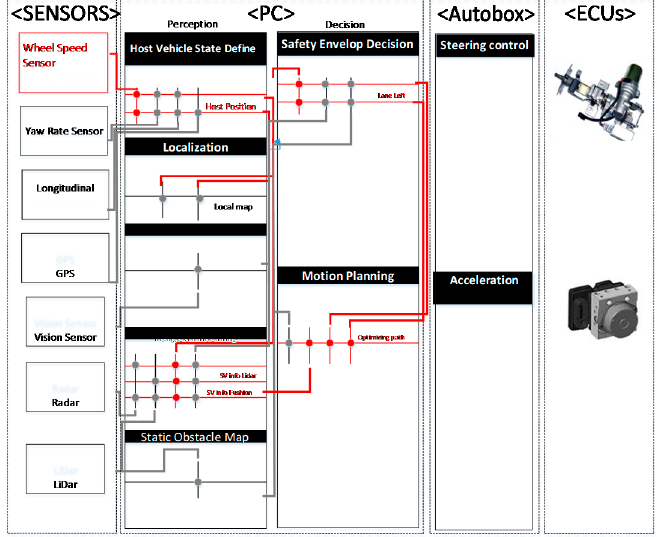
Figure 1. Autonomous driving system Fault Propagation Analysis (FPA).